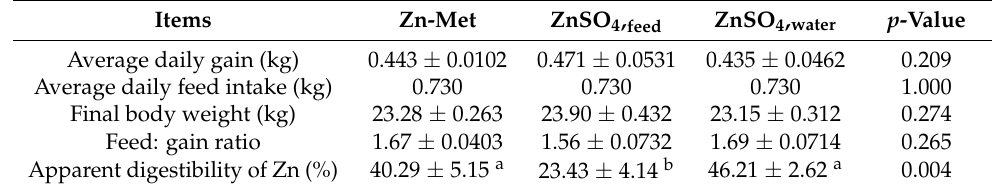
Table 3. Effects of zinc supplementation forms on growth performance and apparent digestibility of Zn in piglets.